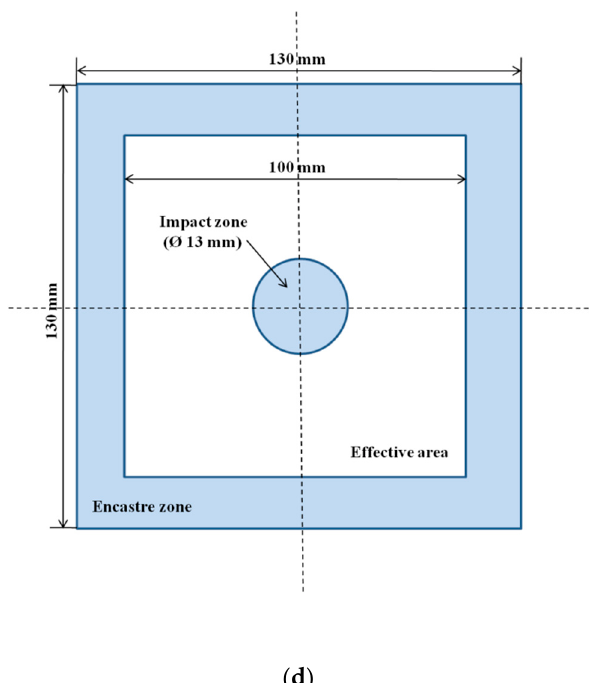
Figure 7. Geometry and dimensions in mm of ( a ) conical, ( b ) hemispherical, and ( c ) blunt projectiles. ( d ) Plate sketch. Dimensions in mm.